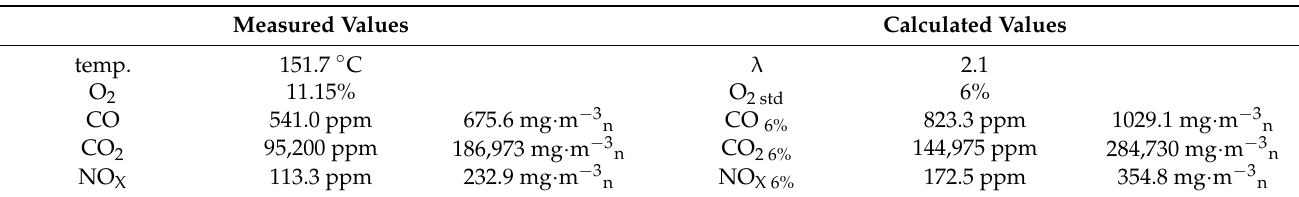
Table 8. Results of measurements of the flue gas composition in the coal furnace of the DT2532 dryer calculated on standard oxygen content of 6%.